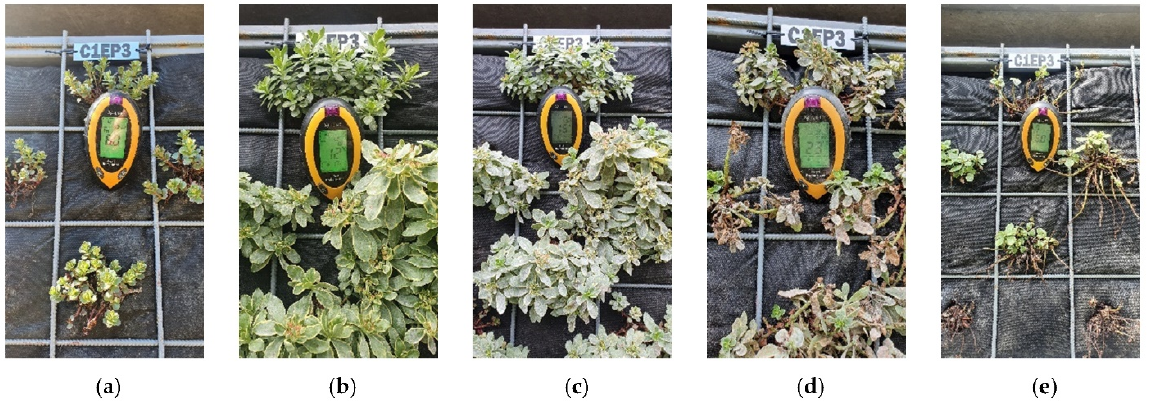
Figure 5. Evolution Sedum spurium ‘Tricolor’ March–June 2020 level 2, eastern facade: ( a ) 12 March